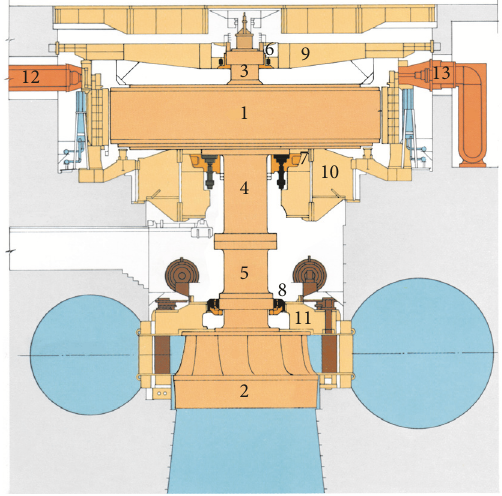
Figure 1: View of a typical 700 MW hydrogenerator of Itaipu Power